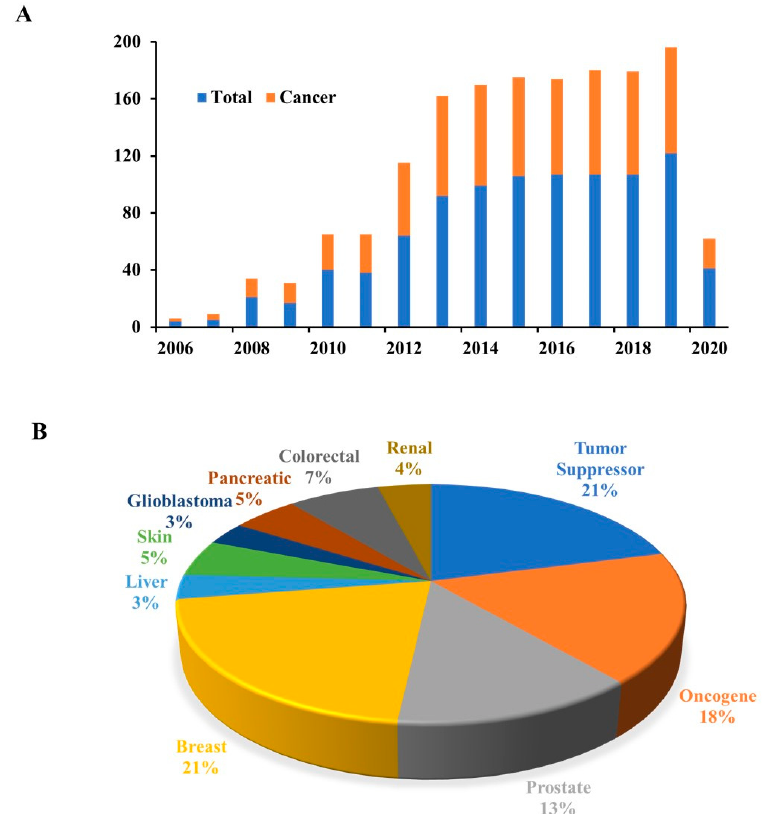
Figure 1. ( A ) Number of peer reviewed articles. Extracted from PubMed, and searched as miR-205, miR-205 in cancer. ( B ) Pie Chart showing distribution of miR-205 articles with di ff erent search criteria. Articles were searched for miR-205 as tumor suppressor in cancer, miR-205 as oncogene in cancer and miR-205 in di ff erent